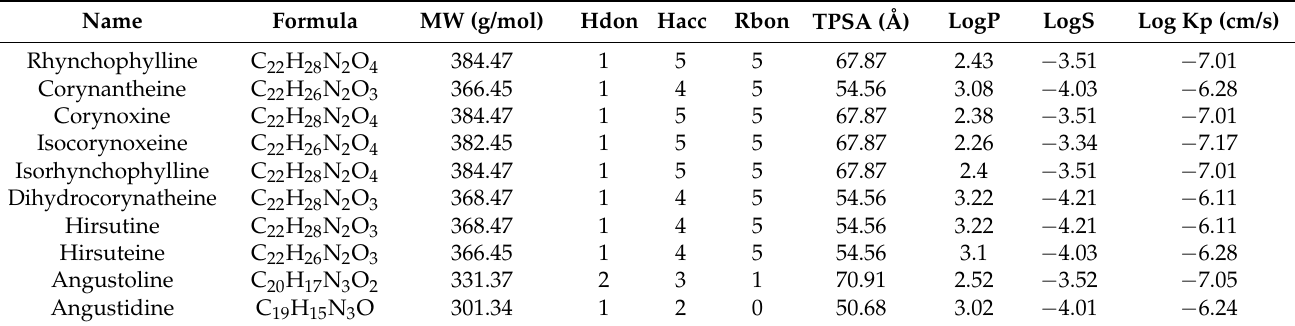
Table 1. Pharmacological and molecular properties of the main alkaloids in